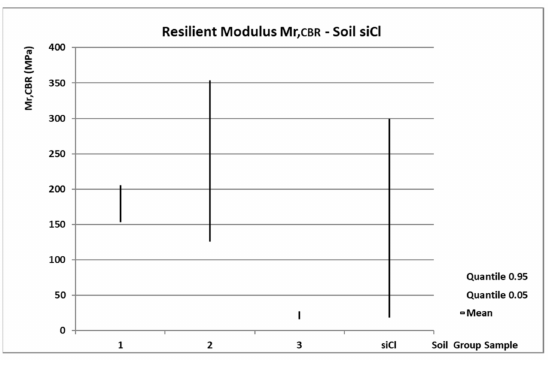
Figure 2. Statistical quantities—mean, 0.05 quantile, 0.95 quantile of M r,CBR for siCl soil.